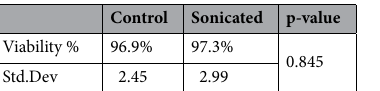
Table 4. Cell viability following a 5-min sonication with LFUS (35-kHz).